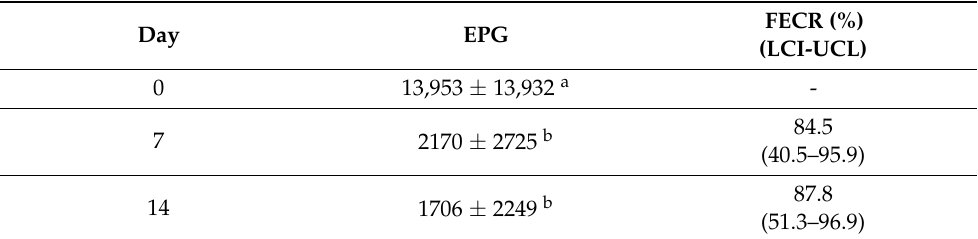
LCL: lower confidence limit, UCL: upper confidence limit. Different letters across different days denote statistically different values ( p ≤ 0.05).